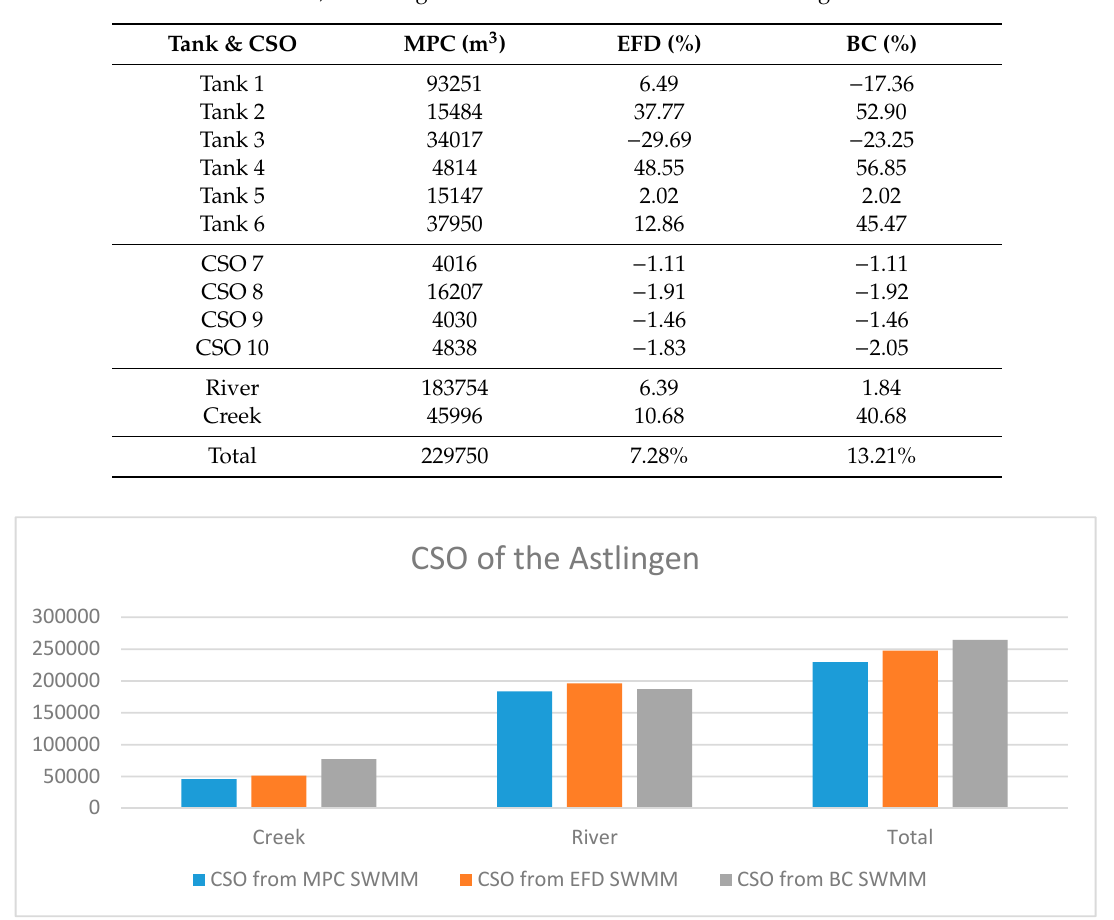
Figure 4. Comparison of CSO volumes for the MPC, EFD, and BC scenarios subdivided by the receiving water body.